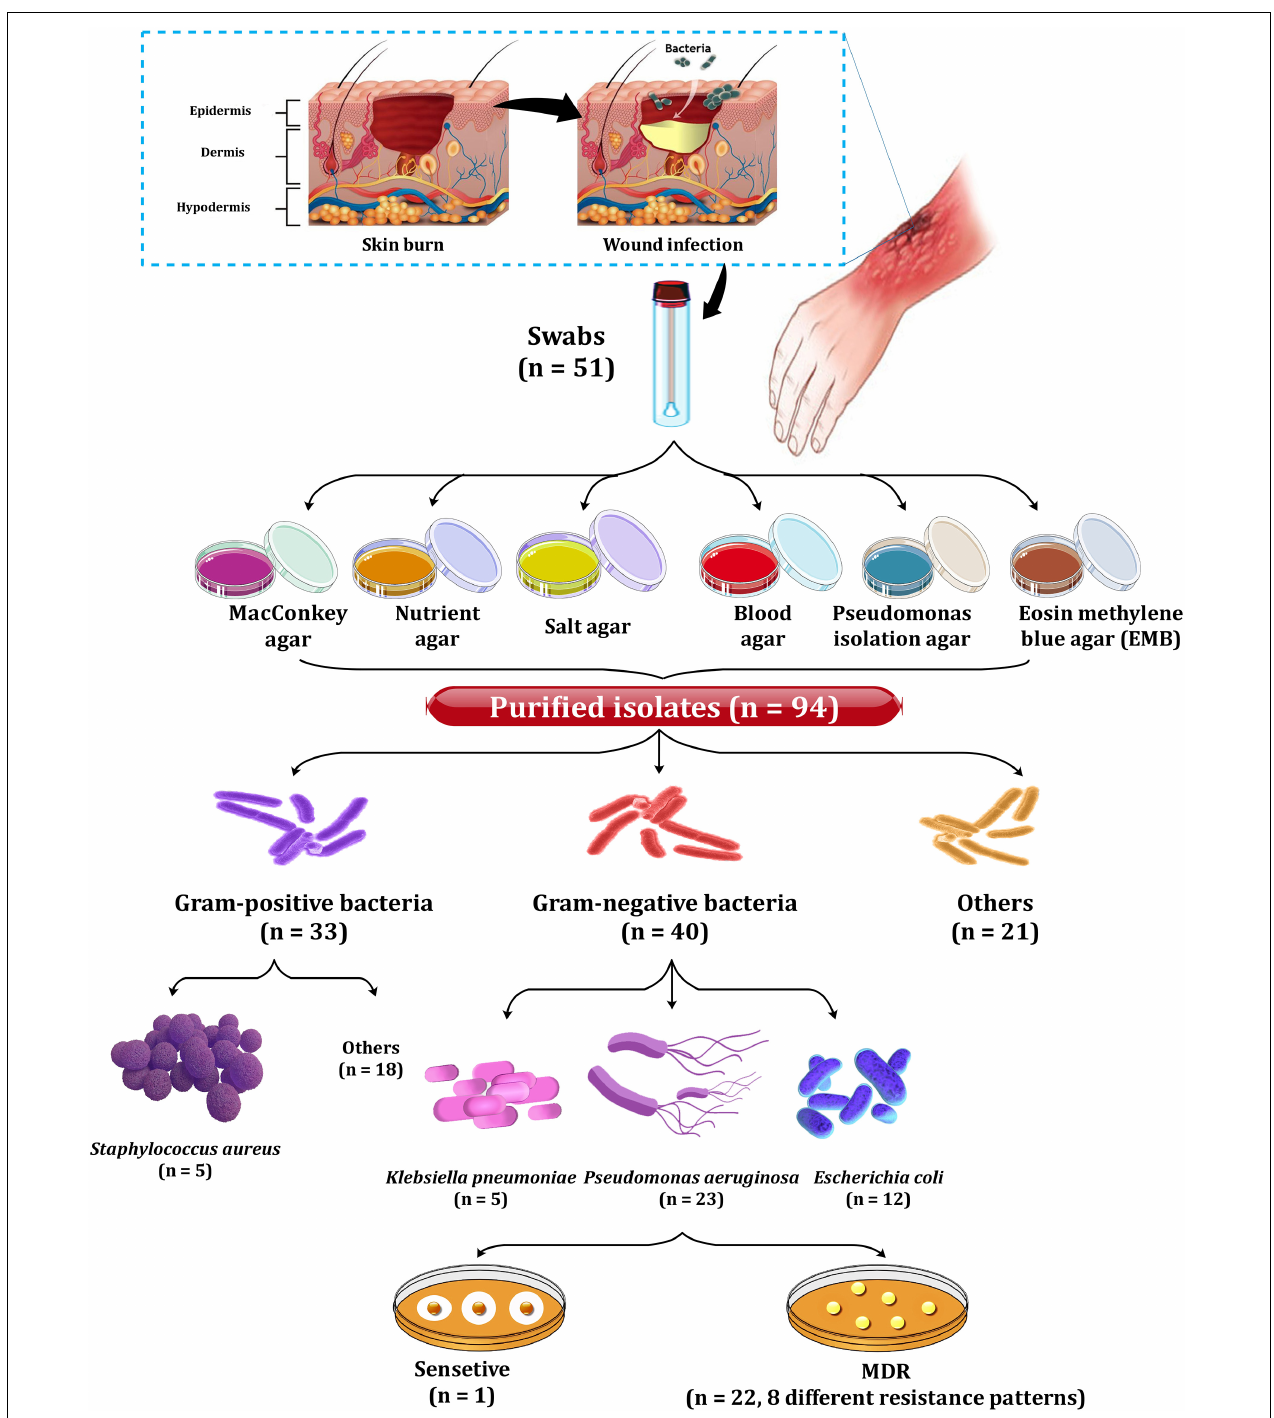
FIGURE 1 | Incidence of the recovered bacterial isolates.